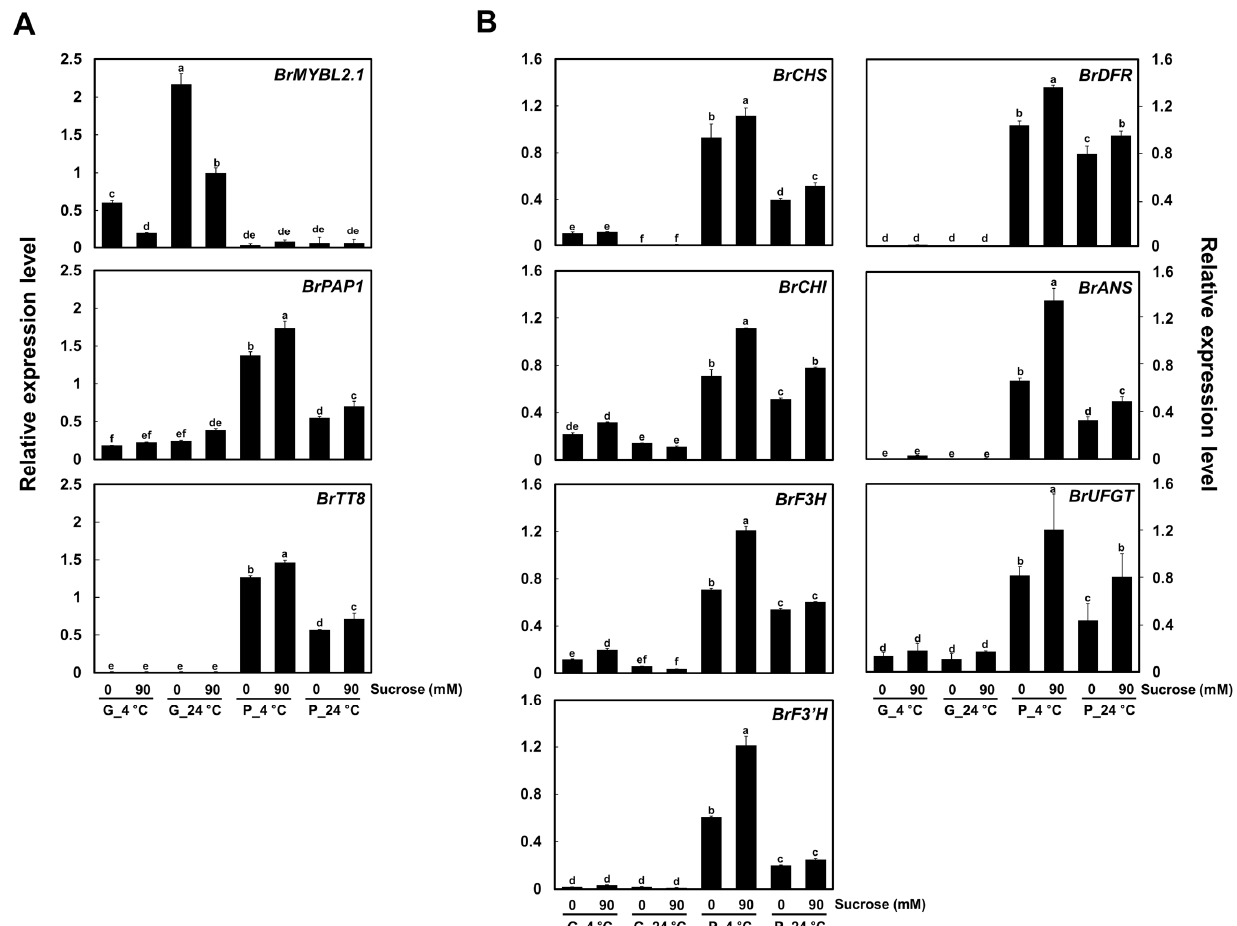
Figure 2. Expression of BrMYL2.1 and other anthocyanin regulatory and biosynthetic genes under various cultivation conditions in green and purple Chinese cabbage. ( A ) Relative transcript levels of the anthocyanin regulatory genes. ( B ) Relative transcript levels of the anthocyanin biosynthetic genes. G, green Chinese cabbage; P, purple Chinese cabbage. Results represent the means ± SD from three independent biological replicates. BrEF1 α was used as the reference gene. Different letters indicate significantly different values ( p < 0.01), as determined by two ‐ way ANOVA followed by Duncan’s multiple range tests.